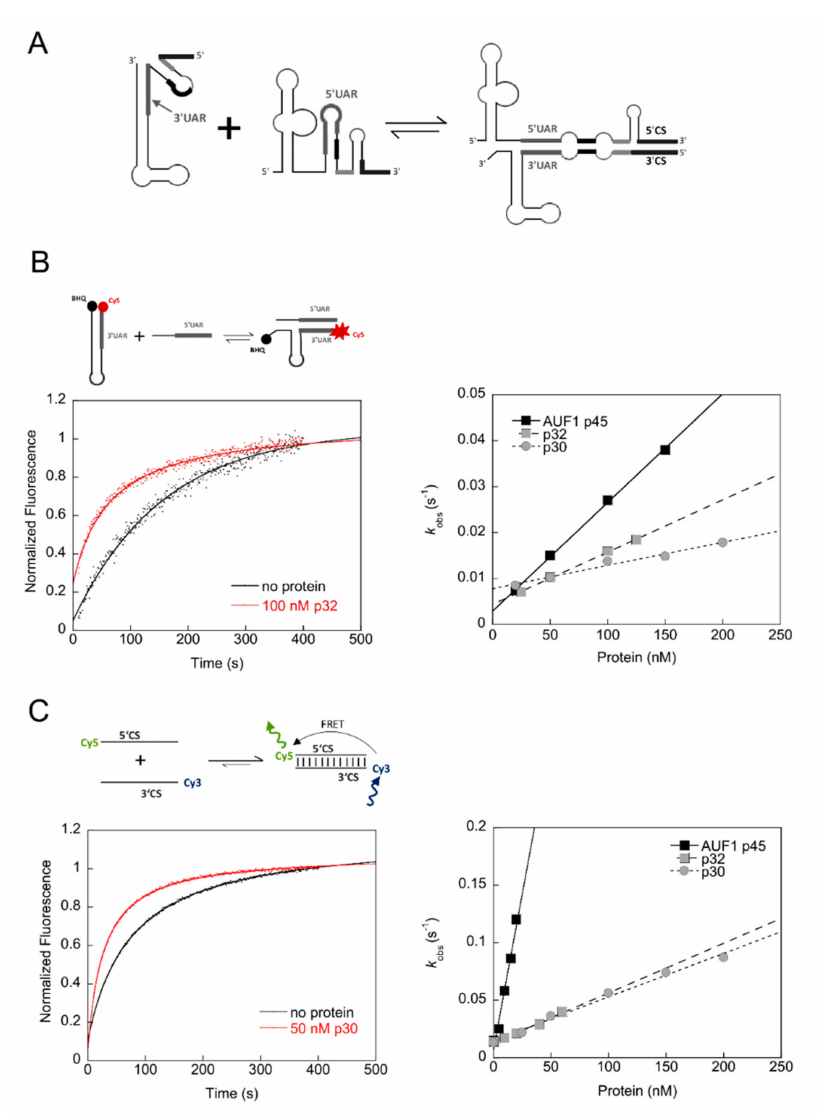
Figure 7. Mosquito proteins p30 and p32 exhibit RNA chaperone and RNA annealing activities. ( A ) Scheme of the structural rearrangement of the 5 (cid:48) and 3 (cid:48) termini, specifically of the 5 (cid:48) UAR and 3 (cid:48) UAR, as well as 5 (cid:48) CS and 3 (cid:48) CS elements, during cyclization of the WNV RNA genome. ( B ) (Top) Scheme of the fluorescence-based 3 (cid:48) SL trunc -5 (cid:48) UAR chaperone assay to detect protein-mediated conformational rearrangement of WNV RNA by dequenching of Cy5. (Bottom) Exemplary kinetic traces with Cy5 and BHQ (black hole quencher) labeled 3 (cid:48) SL trunc incubated with or without 100 nM of p32. Following the addition of 5 (cid:48) UAR RNA the fluorescence signals were measured, plotted as a function of time, and fitted according to a first-order reaction (no protein, Equation (2)) or second-order reaction (in the presence of protein, Equation (3)). (Right) The observed rate constants k obs (s − 1 ) that were measured for the RNA chaperoning reaction in the presence of AUF1 p45, p30, or p32 were plotted as a function of the protein concentration. ( C ) (Top) Scheme of the fluorescence-based 5 (cid:48) CS-3 (cid:48) CS RNA annealing assay to analyze the hybridization of the CS cyclization sequences. Annealing of the complementary 5 (cid:48) - and 3 (cid:48) CS RNAs that are fluorescently labeled with Cy5 and Cy3, respectively, leads to a detectable FRET signal. (Bottom) Exemplary kinetic traces of the RNA–RNA interaction in the absence or presence of 50 nM p30. The fluorescence signals were analyzed according to a second-order reaction (Equation (3)). (Right) The observed rate constants k obs (s − 1 ) that were measured for the RNA annealing reaction in the presence of AUF1 p45, p30, or p32 were plotted as a function of the protein